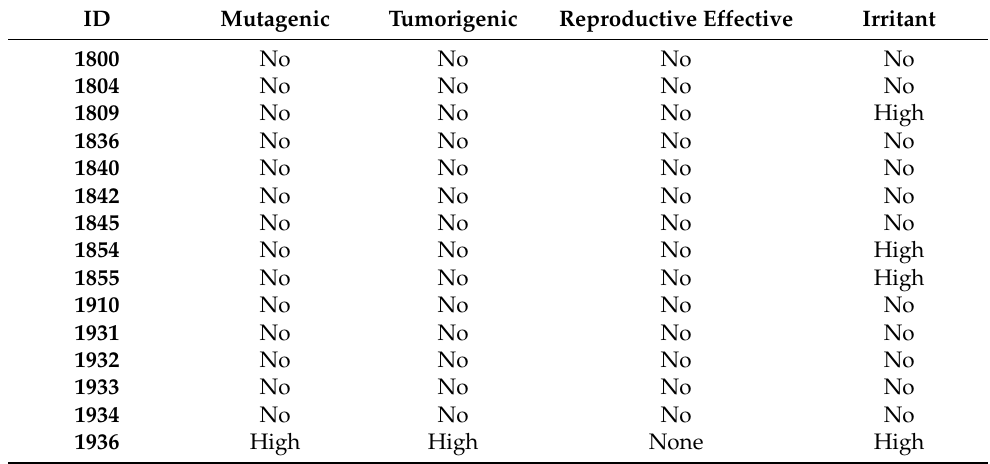
Table 8. Toxicity evaluation for compounds considered active and multitarget for A. gossypii